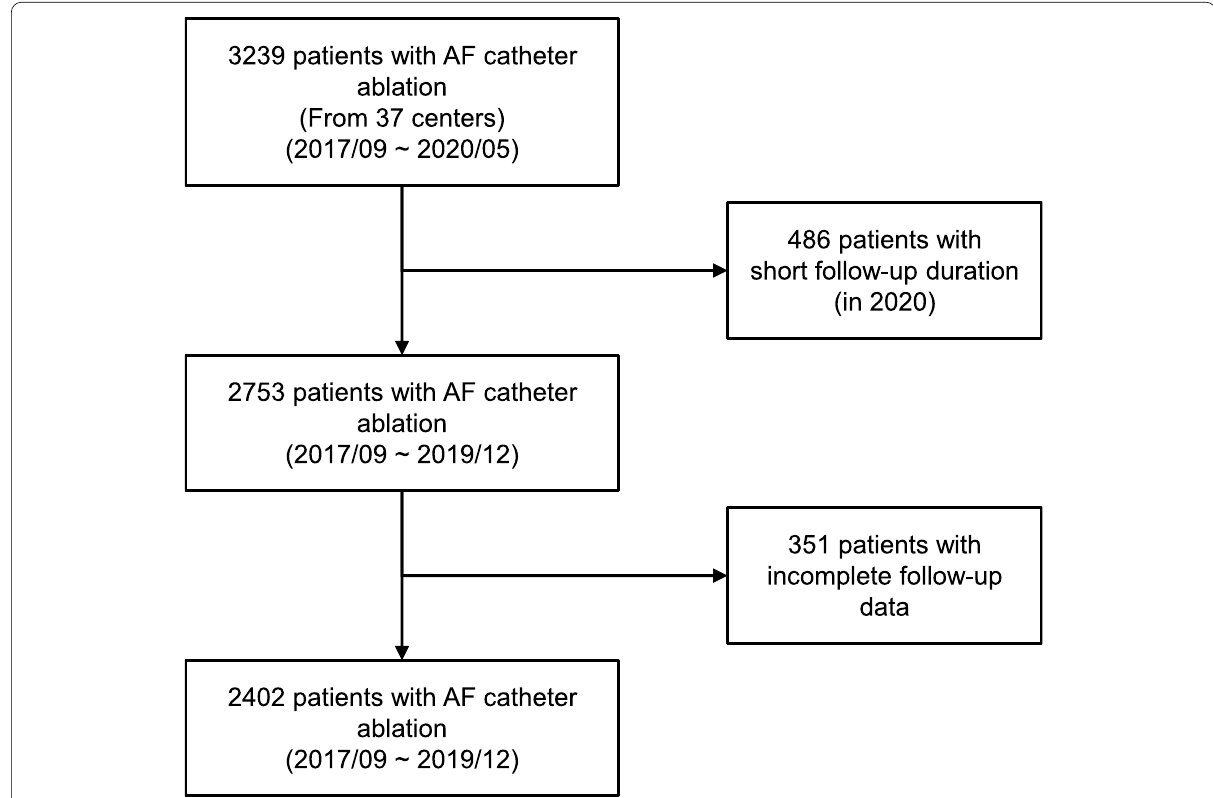
Fig. 1 Flow diagram for study subjects. AF, atrial